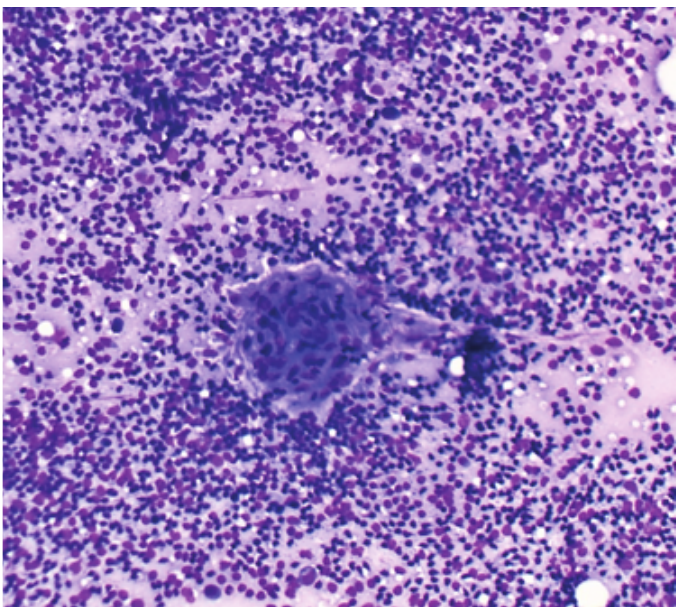
Figure 2 : Photomicrograph showing epithelioid cell granuloma (Pattern A); 100x (MGG).